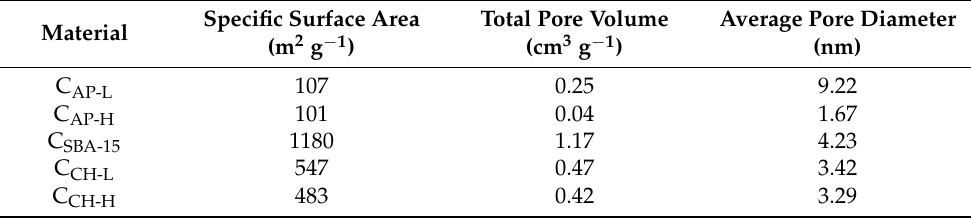
Table 2. Textural parameters of C AP-L , C AP-H , C SBA-15 , C CH-L , and C CH-H .